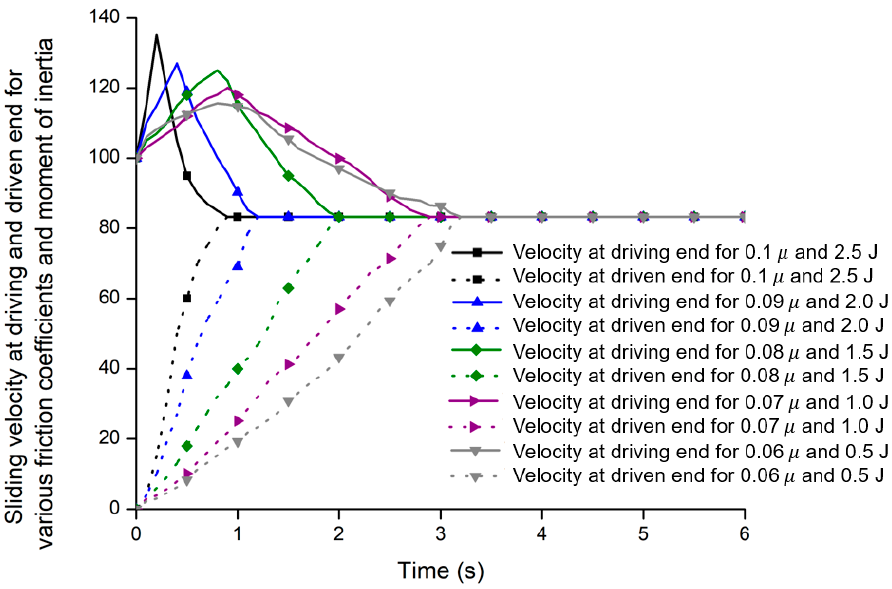
Figure 11. The sliding velocity of the clutch at driving and driven end.